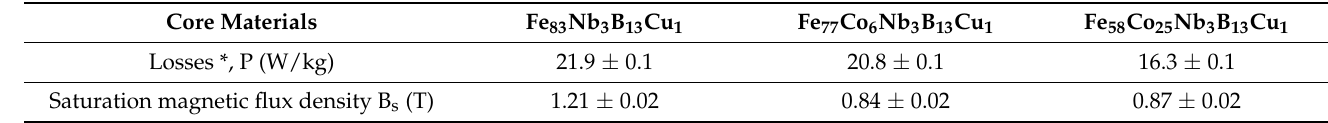
Table 3. Choke cores magnetic materials parameters.